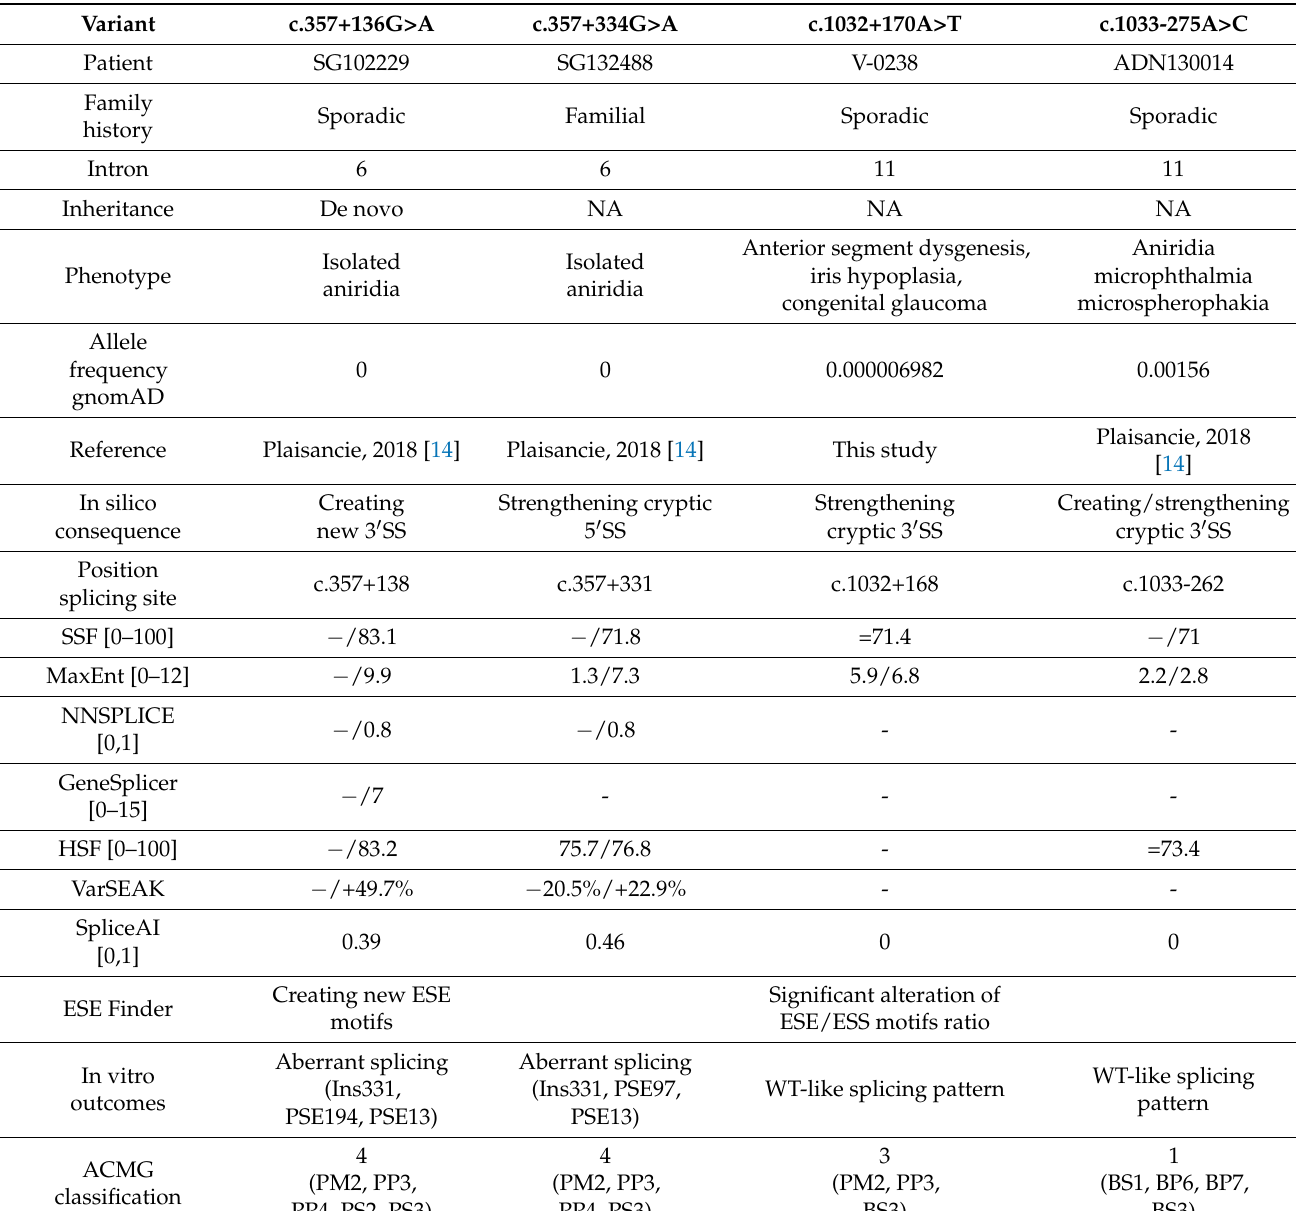
Table 1. Summary of the identified deep-intronic variants in PAX6 , in silico predictions, and the main in vitro outcomes using multi-exonic